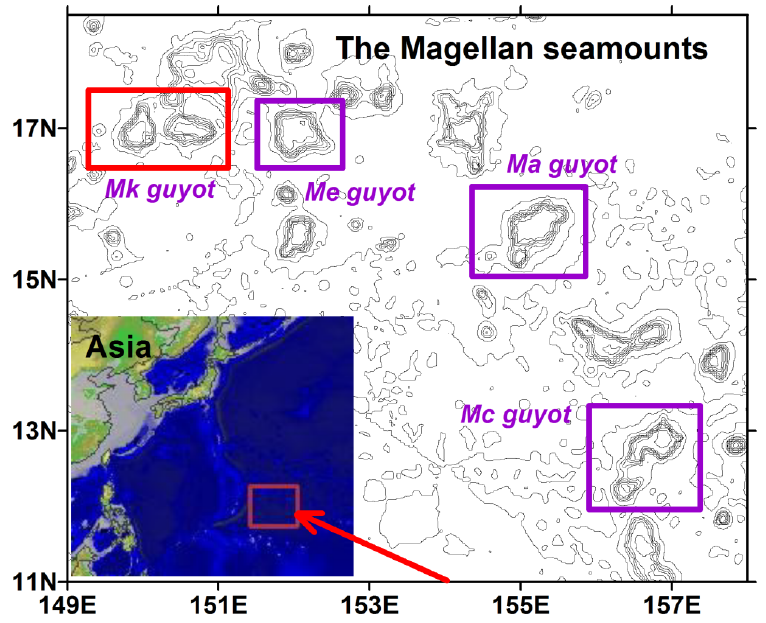
Figure 1. The selected guyots on the Magellan seamounts. Each guyot has an area of approximately 3000 km 2 to 4000 km 2 ; the sampling locations are located away from each other by approximately 1 km to 10 km.